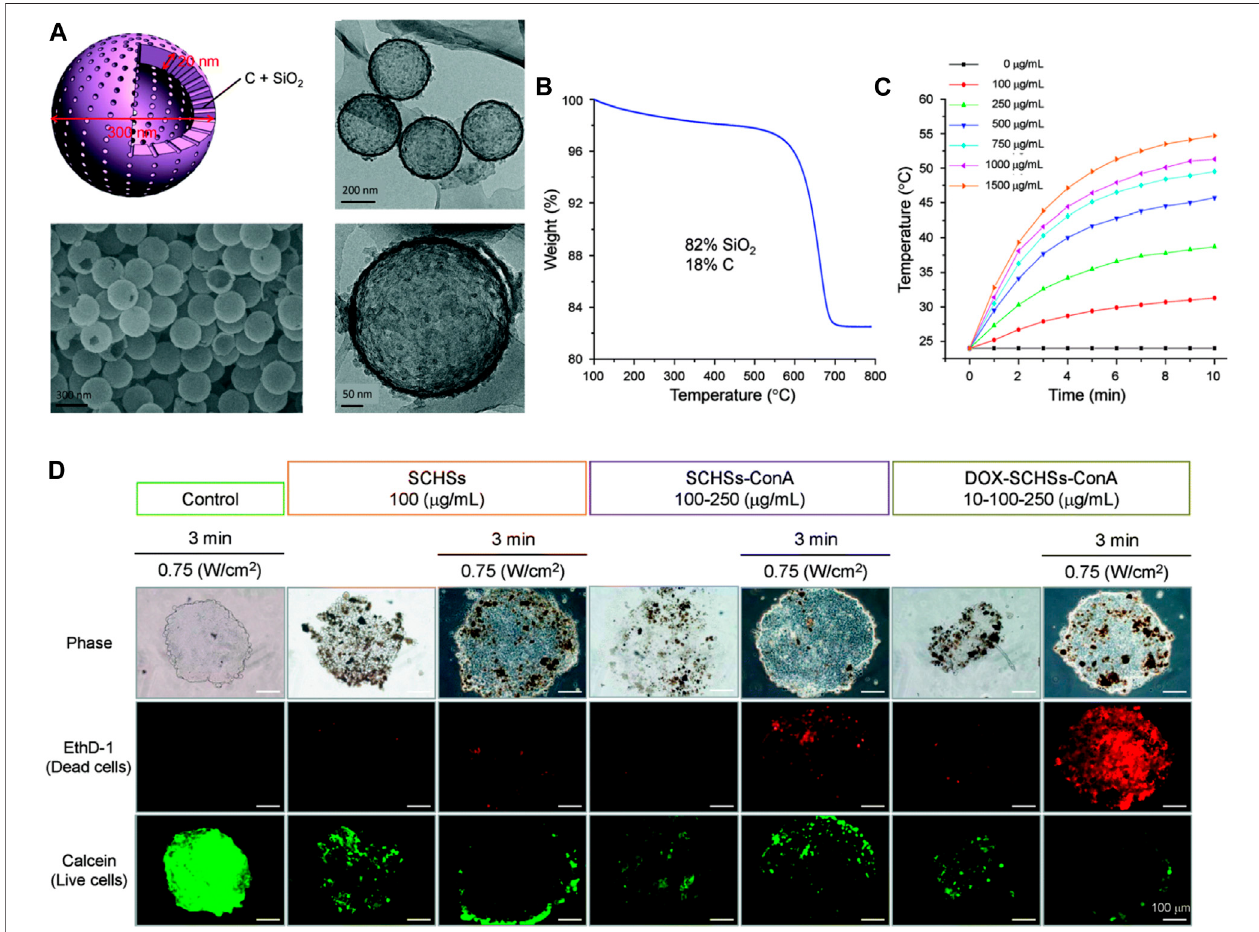
FIGURE 10 | (A) Morphology of a silica – carbon hollow sphere. (B) Thermogravimetric analysis (TGA) curve showing the thermal decomposition of SCHSs in air. Approximately 82% mass of silica (SiO 2 ) remains at a temperature of 800 ° C. (C) Temperature-time curves for media under NIR illumination for various concentrations (100 – 1,500 μ g ml − 1 ) of SCHSs. (D) Cell viability of chemo-photothermal treatment on in vitro 3D MCTSs, representative fl uorescence images of calcein AM and EthD-1 co-stained Huh-7 cells. Reprinted with permission from Chen et al. (2018). Copyright (2018) Royal Society of